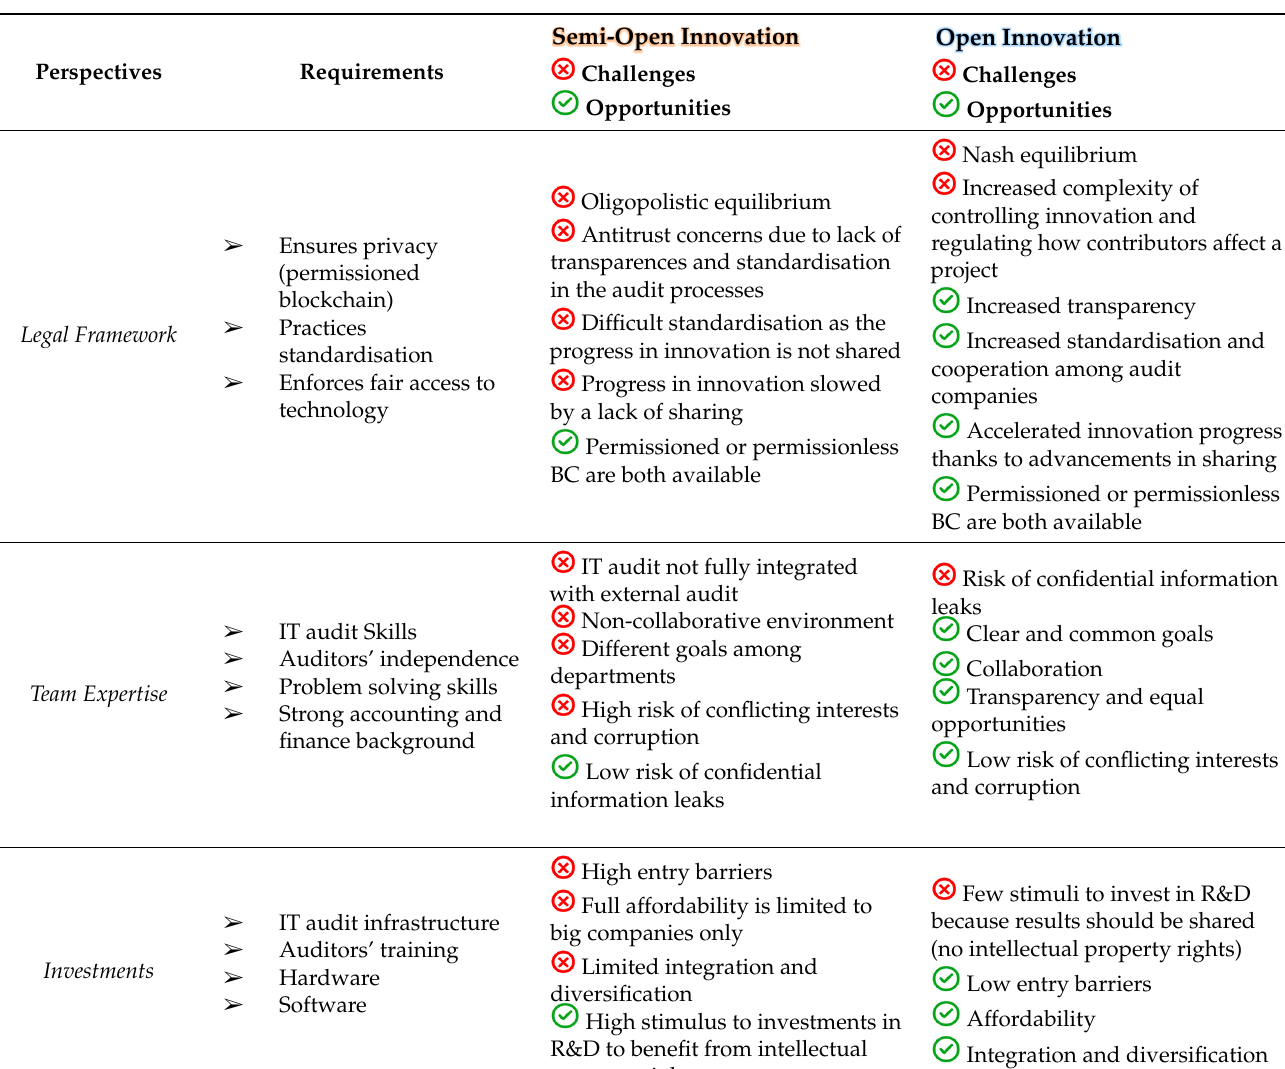
Table 3. Semi ‐ Open Innovation and Open Innovation paradigms in the external audit market: a strategic matrix.